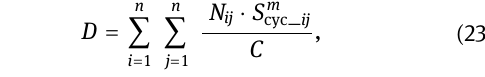
target movement is mainly determined by the rigidity and elasticity of the registration tube.